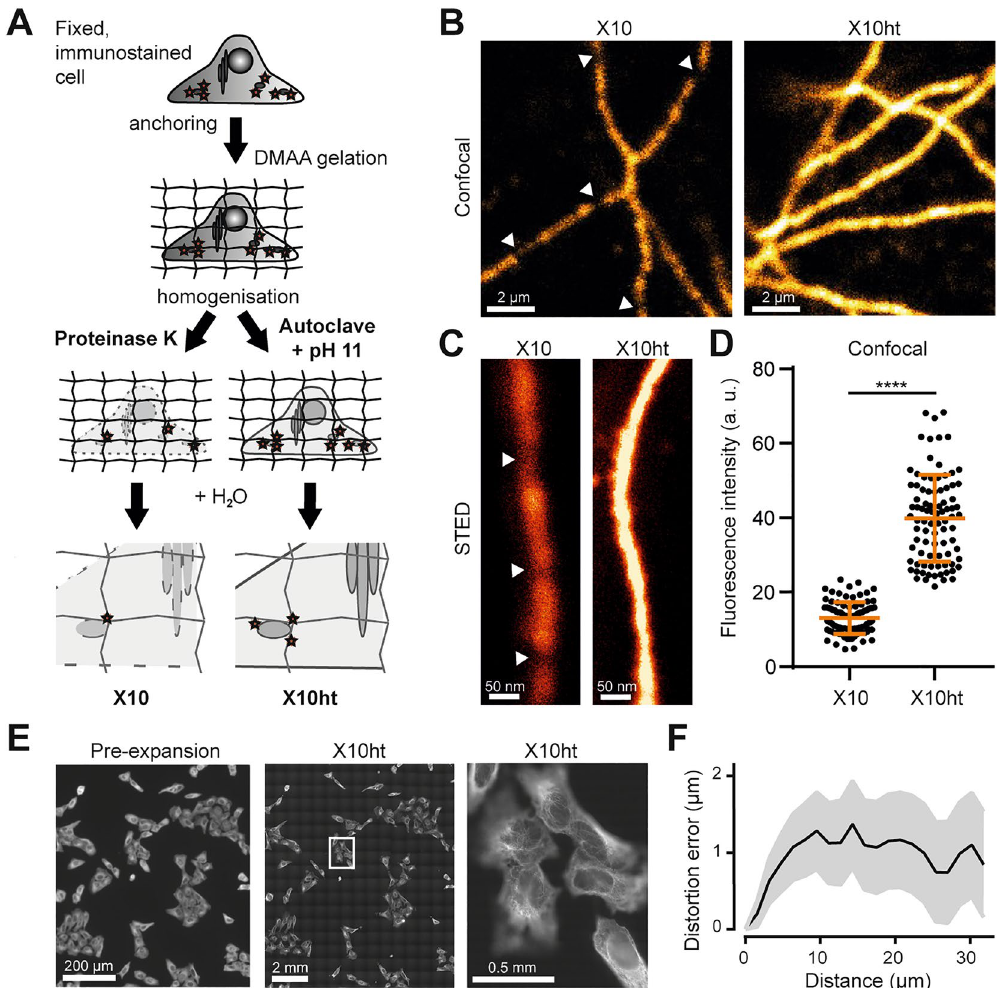
Figure 1. X10ht enables confocal and STED imaging of tubulin immunostained in U2OS cells. ( A ) Scheme describing the differences between the X10 and X10ht protocols. ( B ) Representative images of tubulin under confocal or ( C ) STED imaging, indicating the difference in fluorescence intensity in both methods, what is quantified in ( D ). Using X10ht, we observed that the fluorescence signal appeared as a continuous decoration of the microtubules, while with X10 the loss of fluorophores results in “broken” microtubules (white arrows). N = ~ 90 regions of interest (ROIs) from two gels for each condition. ( E ) Exemplary epifluorescence images of the same region imaged pre- and post-expansion (X10ht) using the same 10 × objective. The region of the detail image is indicated by a white rectangle, showing expanded cells with a 100 × objective. ( F ) Distortion analysis of aligned pre- and post-expansion images. N = 3 automated measurements. Except panel E, scale bars, here and elsewhere, are given including the correction by the expansion factor. Data are presented as single ROI data points, mean ±